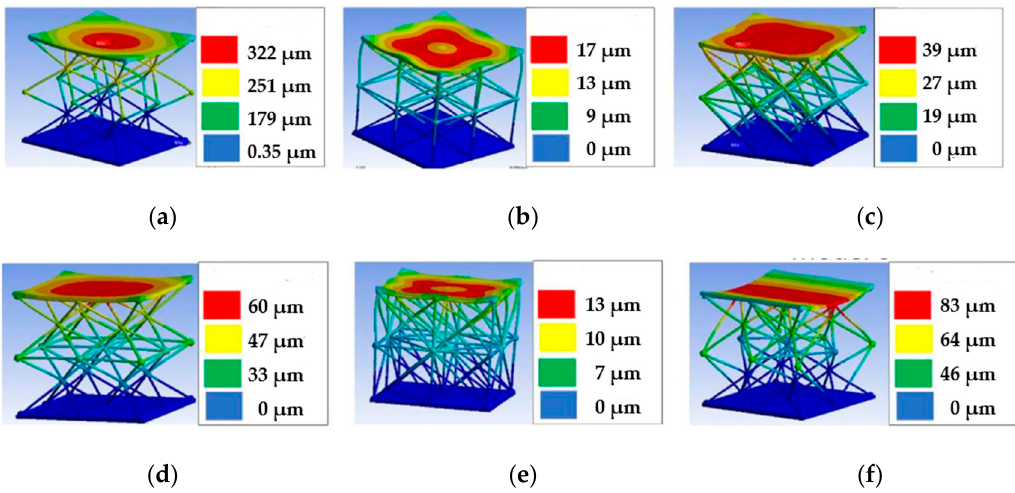
Figure 7. FEA simulations to estimate displacement of six lattice structures [92]: ( a ) model 1; ( b ) model 2; ( c ) model 3; ( d ) model 4; ( e ) model 5; ( f ) model 6.